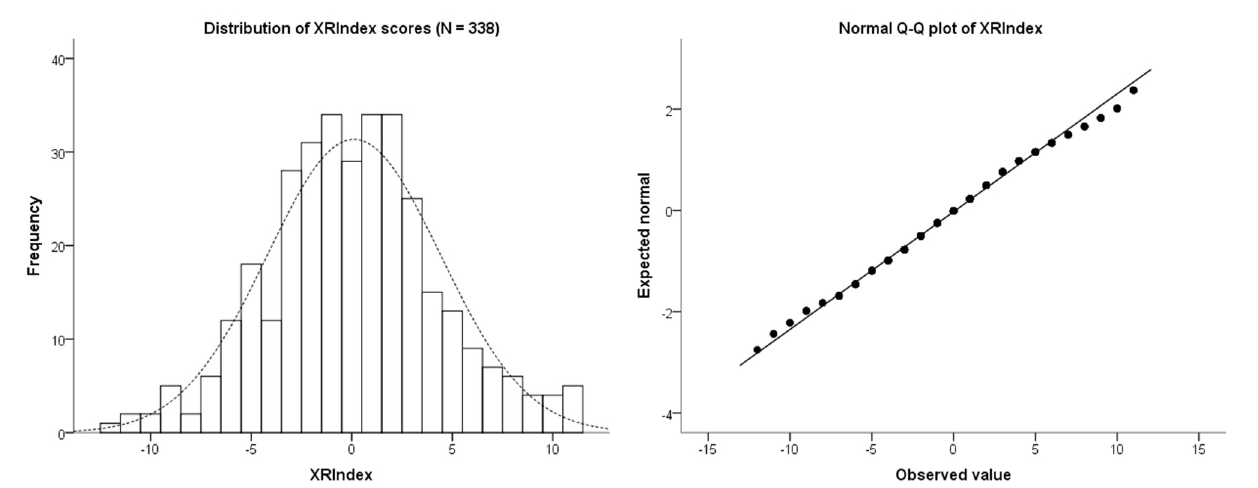
FIGURE 3 | The left hand panel shows a histogram of the distribution of scores for the XRIndex in 338 participants. The right hand panel shows the Normal Q-Q plot of the XRIndex distribution, which in its central part essentially overlaps with the normal distribution.